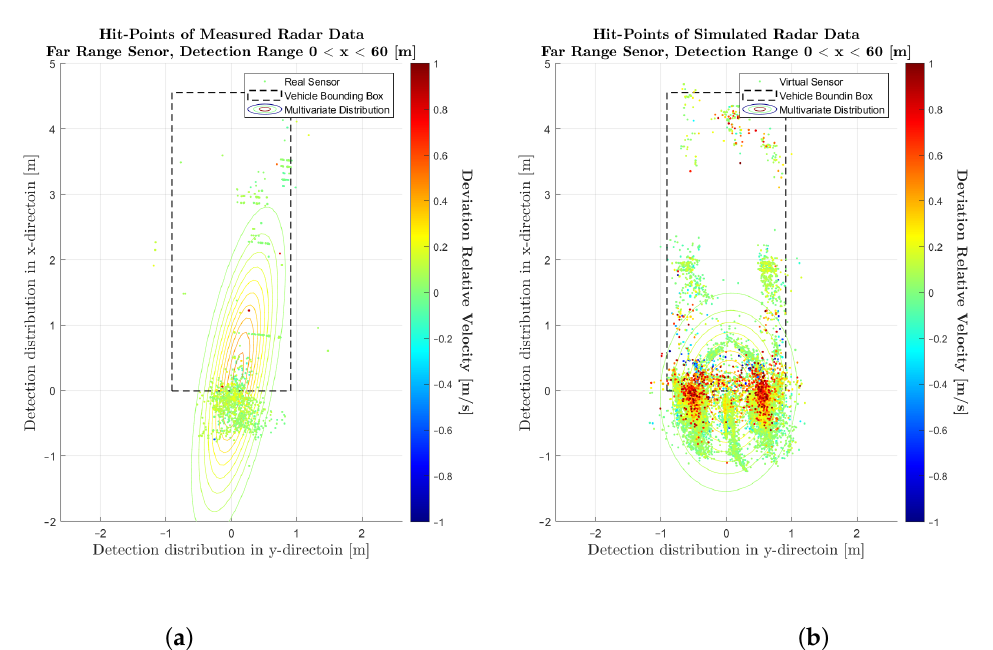
Figure 10. Evaluation of the detections in the range of 0 to 60 m of the far-range radar sensor and sensor model. ( a ) Scatterplot of detections of the real sensor. ( b ) Scatterplot of detections of the sensor